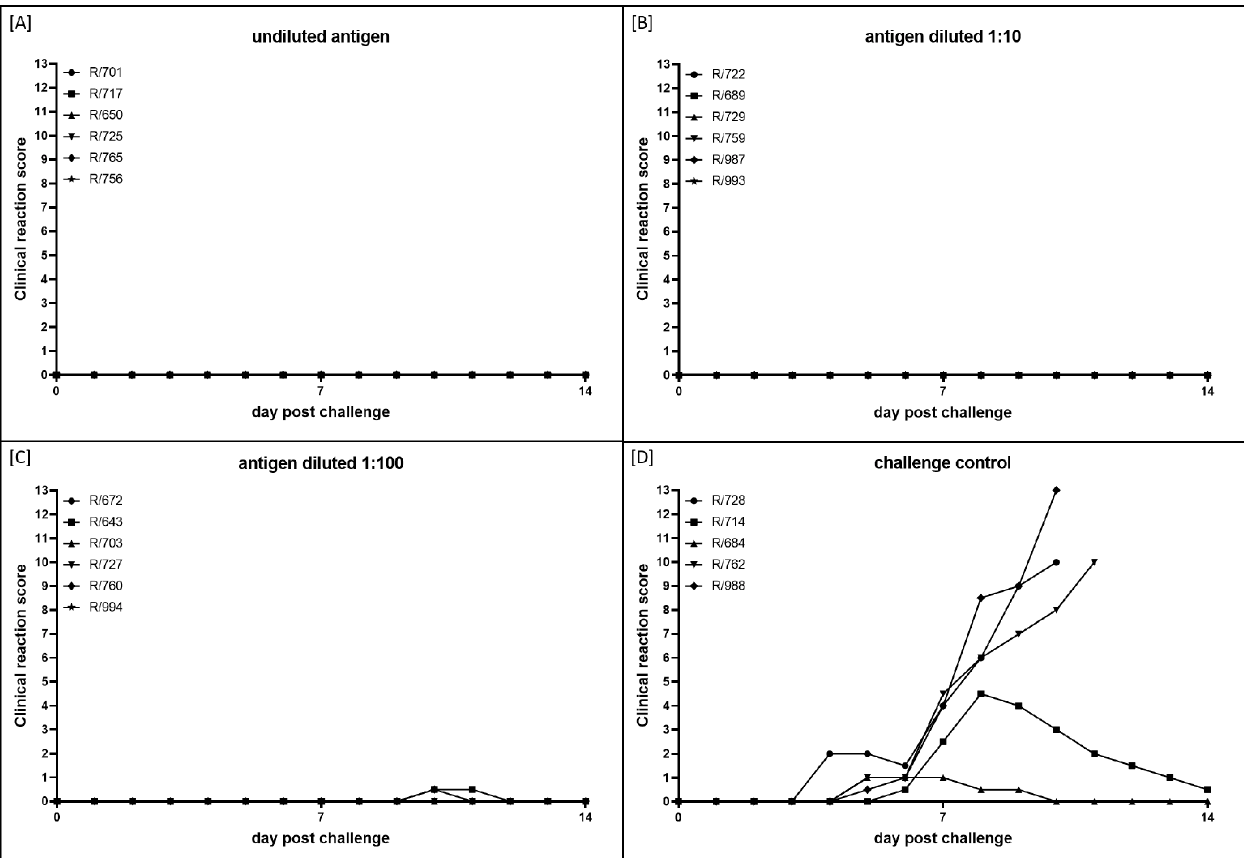
Figure 2. Clinical reaction scores of cattle immunized with inactivated LSDV vaccine candidates with different amounts of antigen. Clinical reaction score was measured daily from 0 until 14 dpc. Animals were inoculated with inactivated LSDV vaccine candidate with different amounts of anti ‐ gen and then challenged with virulent LSDV ‐ Macedonia2016. ( A ) Vaccine virus titer before inacti ‐ vation was 10 6 CCID 50 /mL on BHK ‐ 21 cell line. ( B , C ) Antigen was diluted 1:10 and 1:100, respec ‐ tively, before adjuvant was added. ( D ) Cattle in group D were housed as challenge control group and received PBS instead of vaccine.